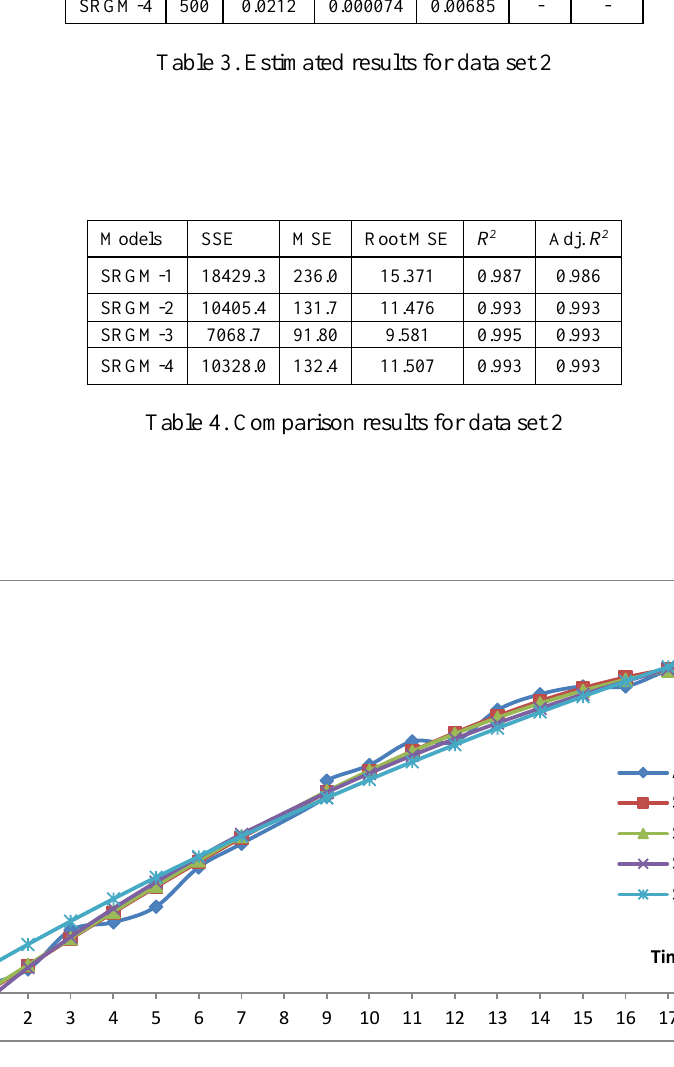
Fig. 1. Goodness of fit curve for data set